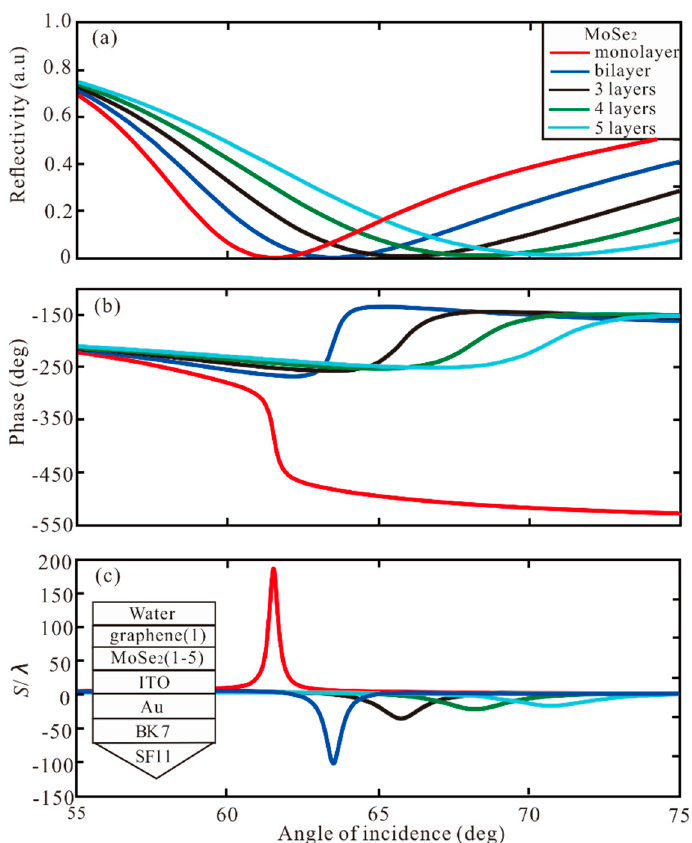
Figure 5. The change of ( a ) reflectivity, ( b ) phase, and ( c ) GH shift with respect to angle of incidence for different number of graphene layers with monolayer of MoSe 2 .